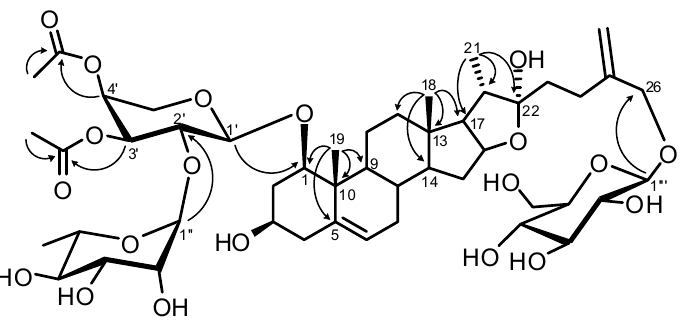
Figure 3. Key HMBC correlations for compound 1